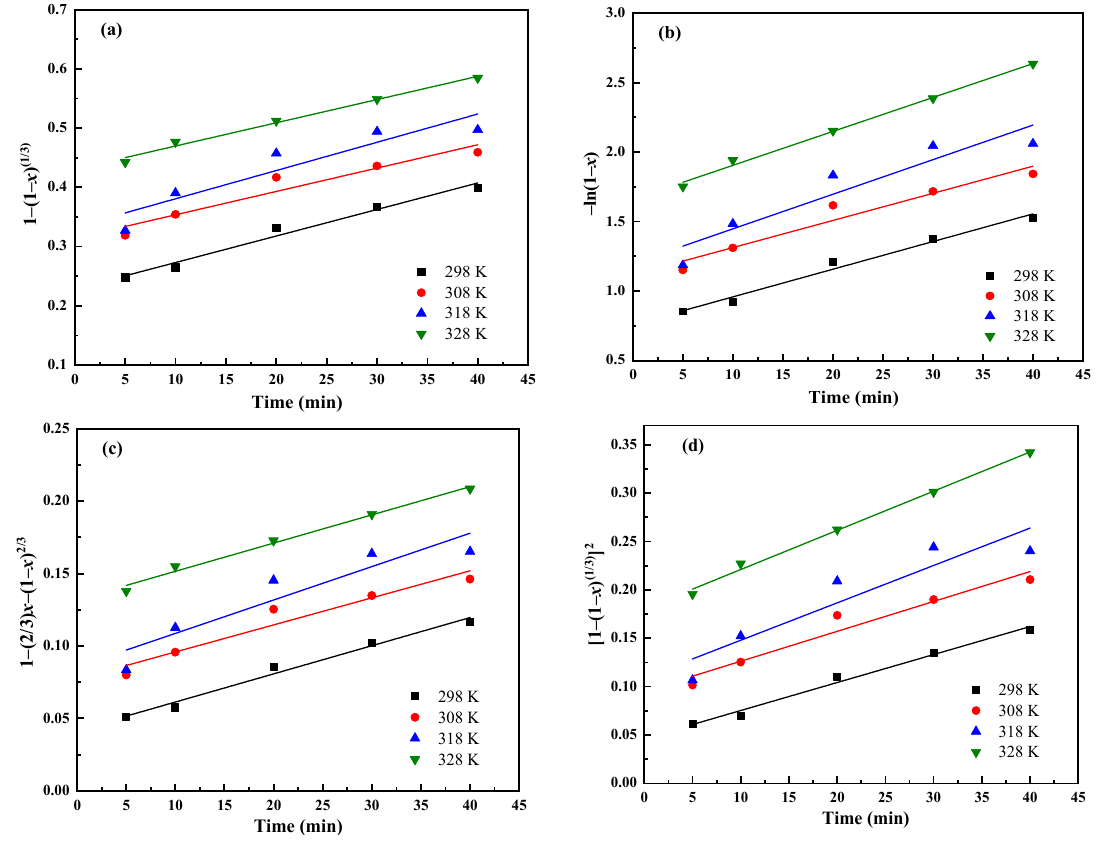
Figure 8. Plots of kinetic models: ( a ) 1 − (1 − x) 1/3 vs. time; ( b ) − ln(1 − x) vs. time; ( c ) 1 − (2/3)x − (1 − x) 2/3 vs. time; ( d ) [1 − (1 − x) 1/3 ] 2 vs. time.